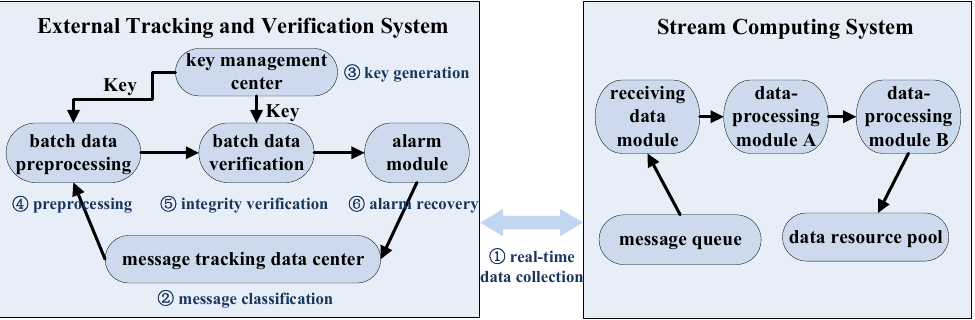
Figure 1. The architecture of external tracking and verification system of stream computing system.